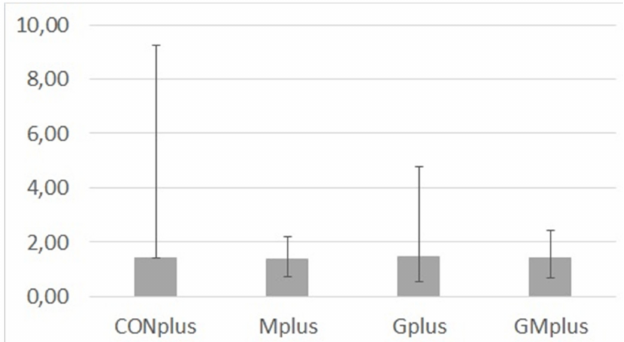
Figure 2. Malondialdehyde (MDA) content ( µ g / g of tissue) in mammary tumours of experimental